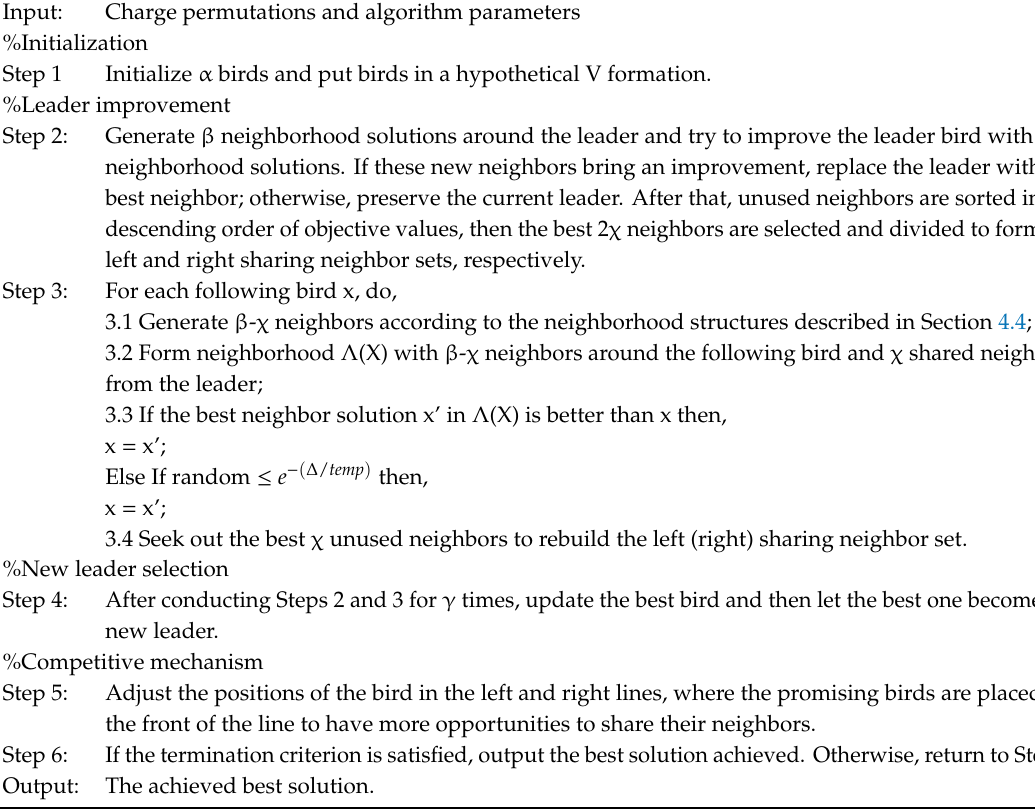
Algorithm 5 Procedure of the improved migrating birds